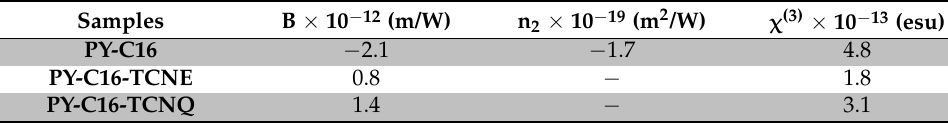
Table 2. Third-order nonlinear parameters of